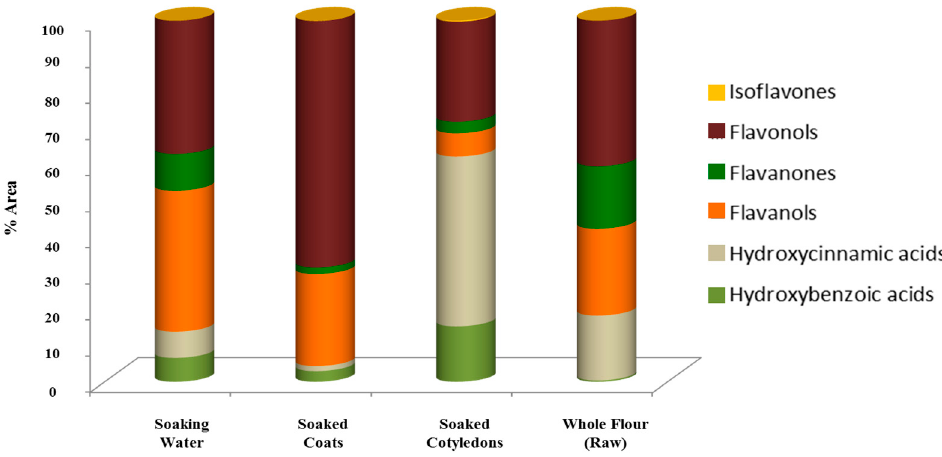
Figure 4. Percentage, %, area of compounds’ classes in different sample’s 22 fractions.